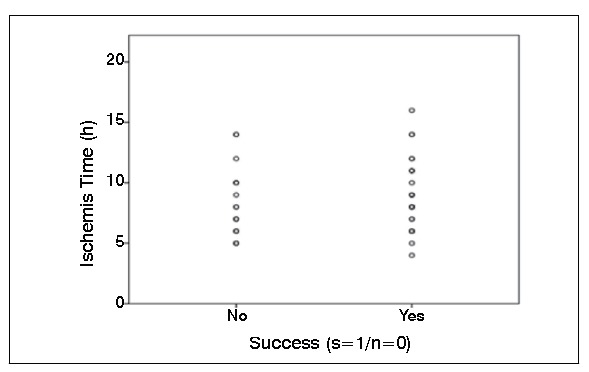
Mean ischemia times.